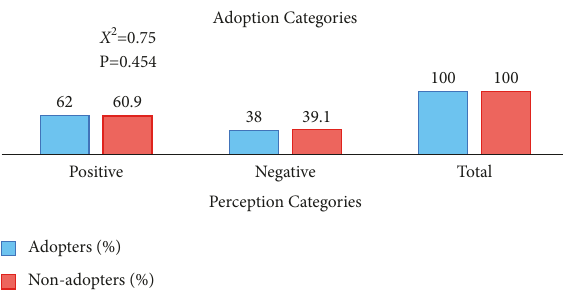
Figure 6: Perception of farmers about dairy technology.